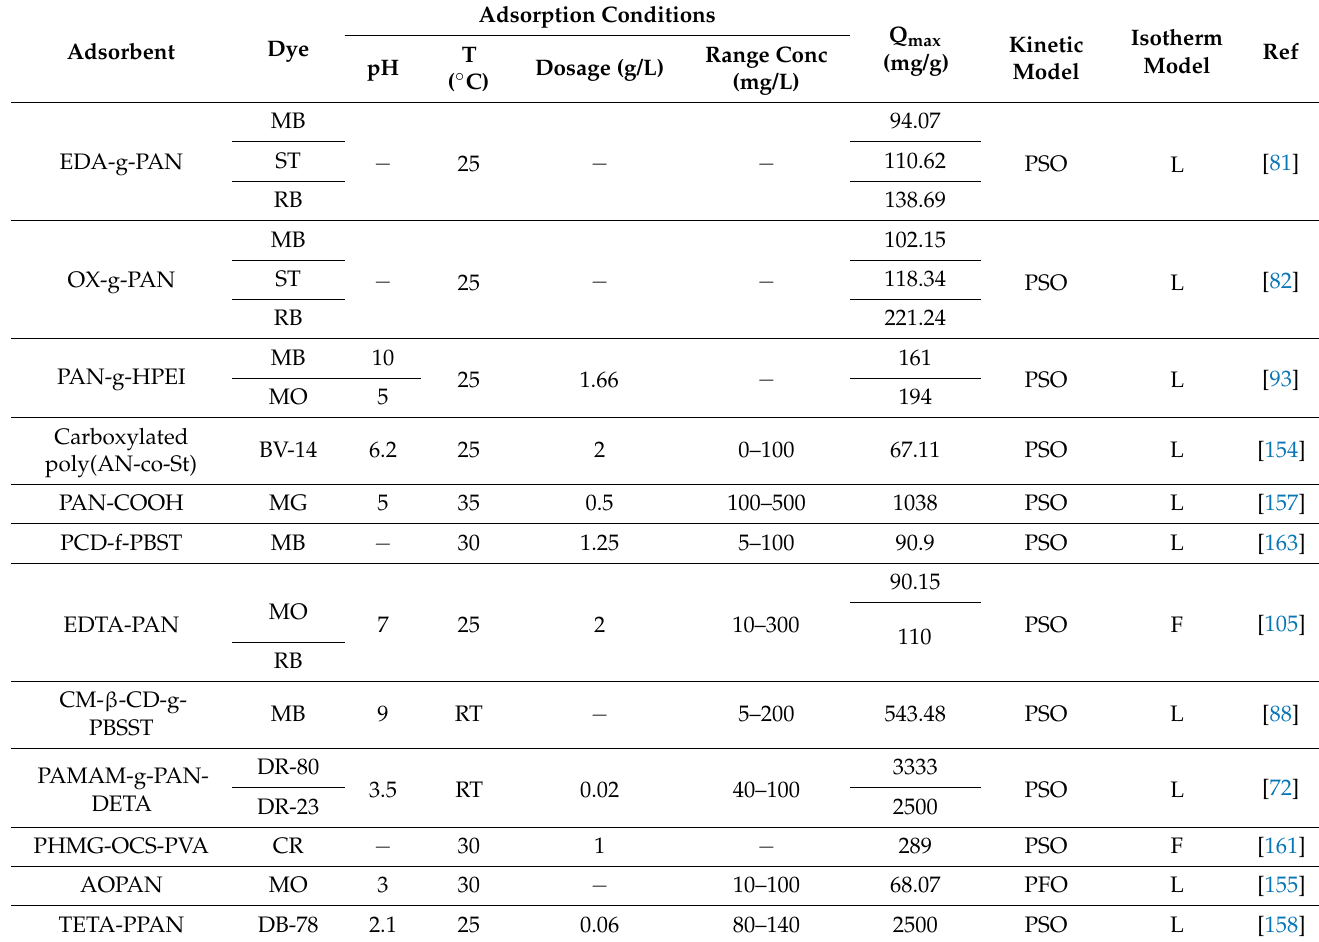
Table 5. Functionalized electrospun polymer nanofibers as adsorbent for removal of dyes.